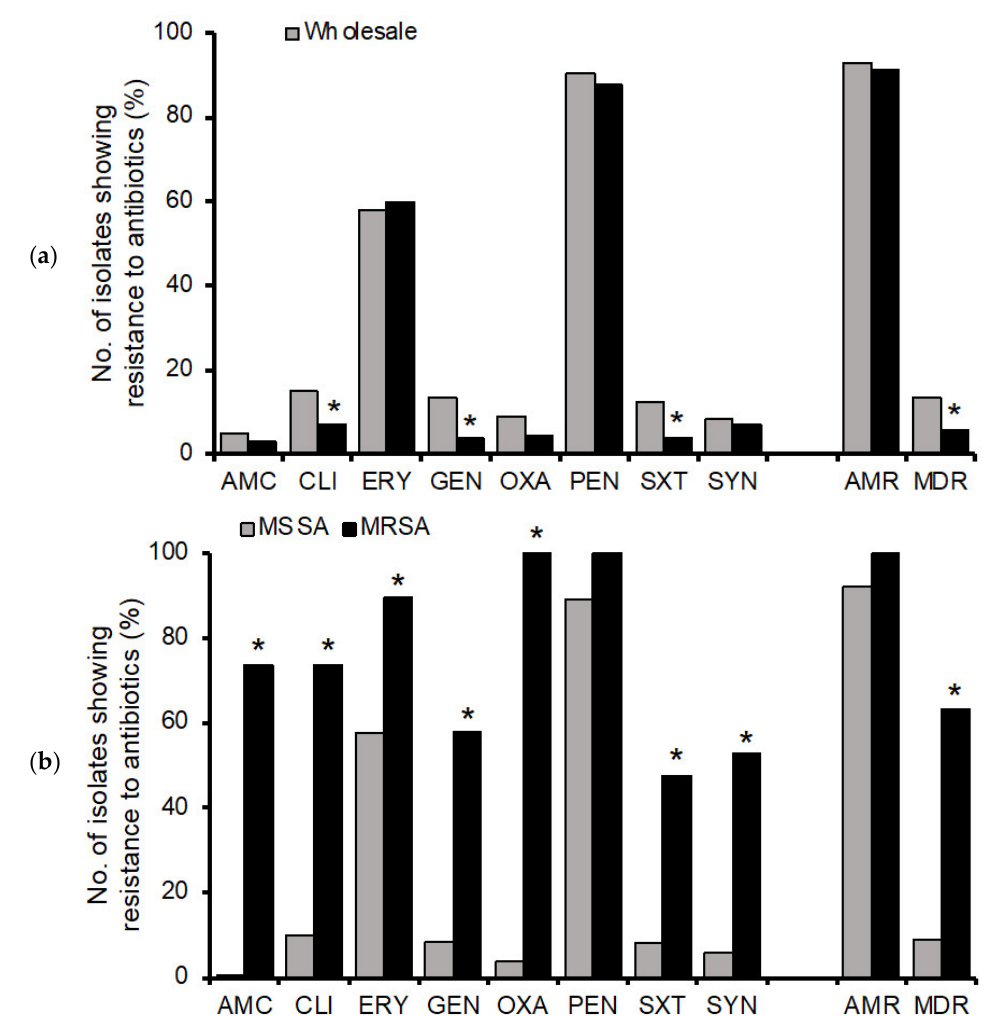
Figure 1. Multidrug resistance patterns of S. aureus isolated from wholesale and retail pork samples ( a ) and different groups, MSSA and MRSA ( b ), in Wuhan, China. AMC, amoxicillin/clavulanate; CLI, clindamycin; ERY, erythromycin; GEN, gentamicin; OXA, oxacillin; PEN, penicillin; SXT, trimethoprim/sulfamethoxazole; SYN, quinupristin/dalfopristin. AMR, resistant to at least one antimicrobial; MDR, resistant to three or more classes of antimicrobials. * Indicates p < 0.05.